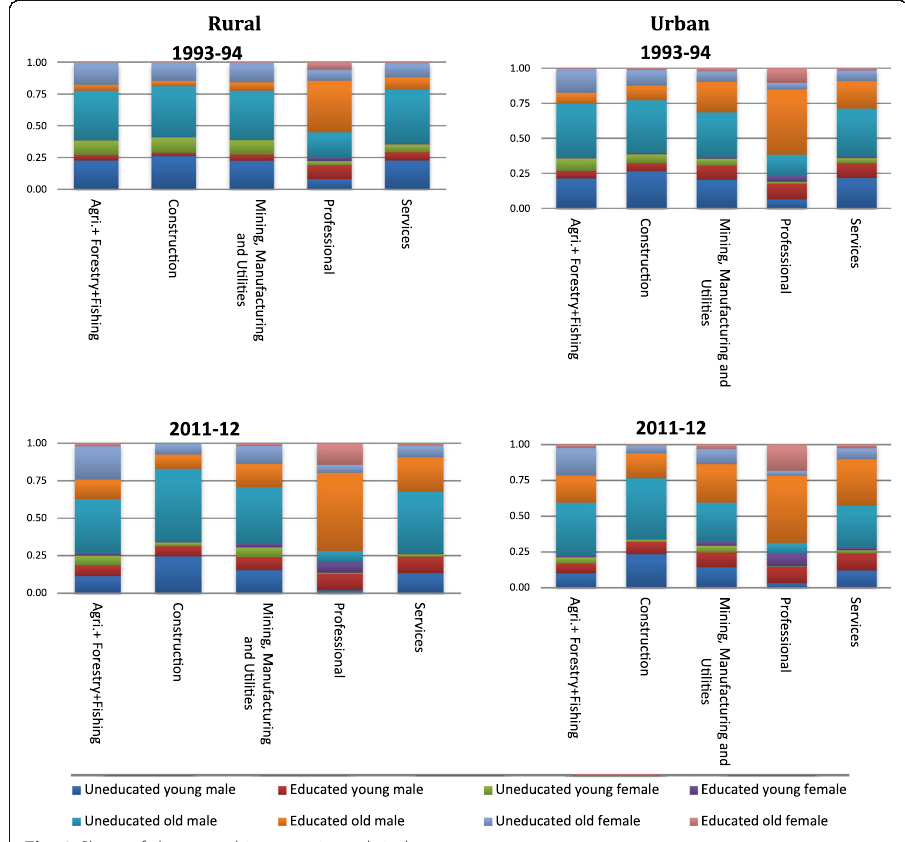
Fig. 3 Share of demographic group in each